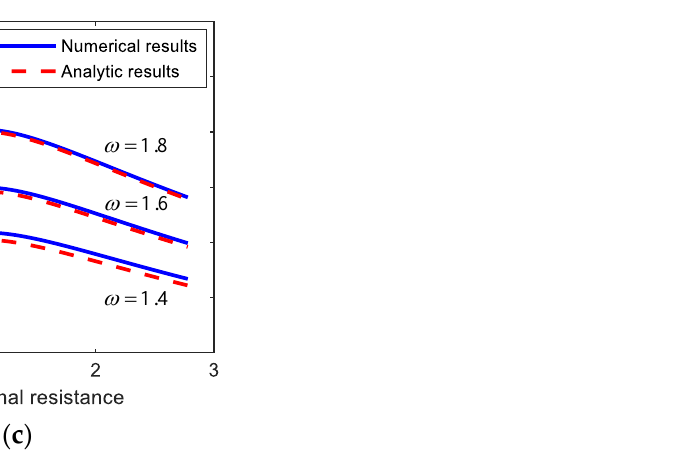
Figure 7. Plots of the external load resistance versus the average output power harvested from ( a ) period-1 T , ( b ) period-3 T , and ( c ) period-5 T motions of the electromagnetic energy harvester. The results are obtained by numerical integration (blue solid lines) and the semi-analytic approach (red dashed lines) and compared to each other. For each motion, the comparisons in between are made with three different forcing conditions: ( a ) ( A , ω ) = (0.012, 0.6), (0.02, 0.7), (0.03, 0.8), ( b ) ( A , ω ) = (0.012, 1.0), (0.02, 1.2), (0.03, 1.4), ( c ) ( A , ω ) = (0.012, 1.4), (0.02, 1.6), (0.03, 1.8). The solid circle points indicate the optimal conditions for the external load resistance with which the output power is maximized.